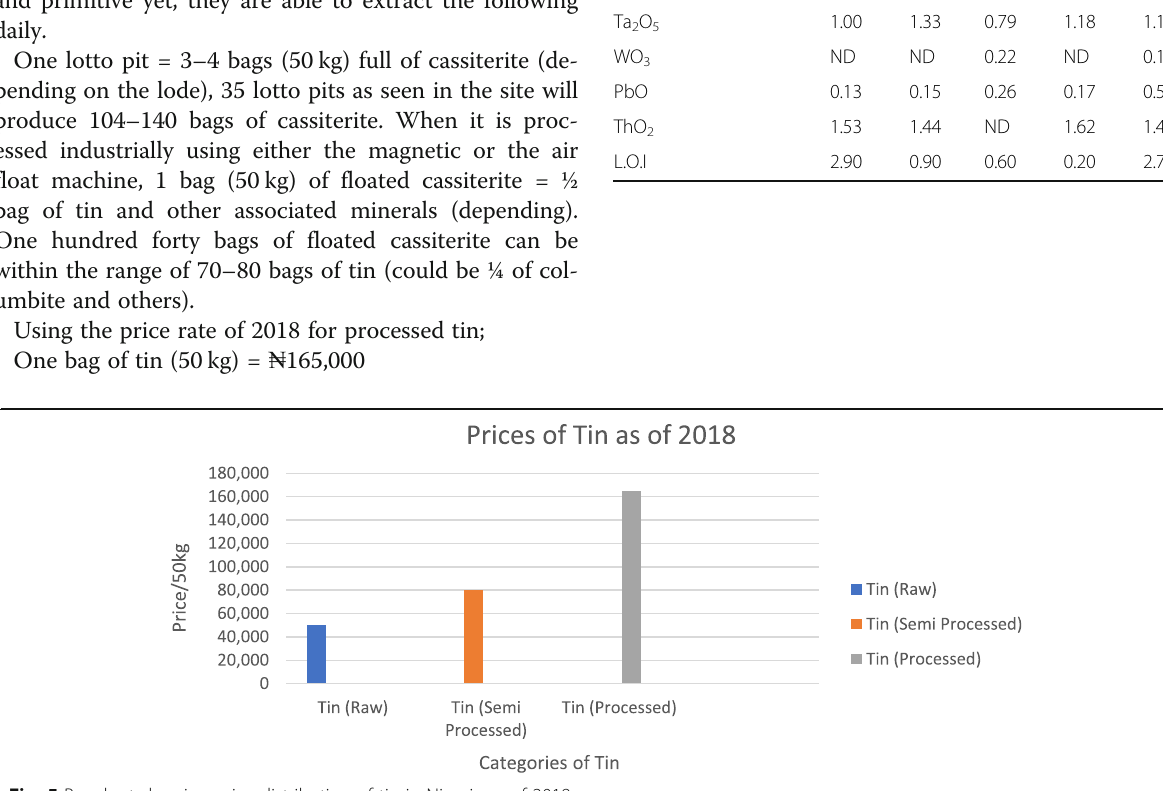
Fig. 5 Bar chart showing price distribution of tin in Nigeria as of 2018